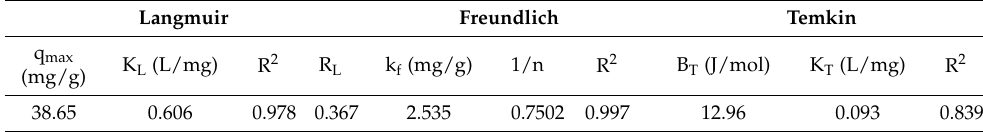
Table 4. Isotherms’ model parameters for the As(V) adsorption on BT-An@Zetag composite. Langmuir